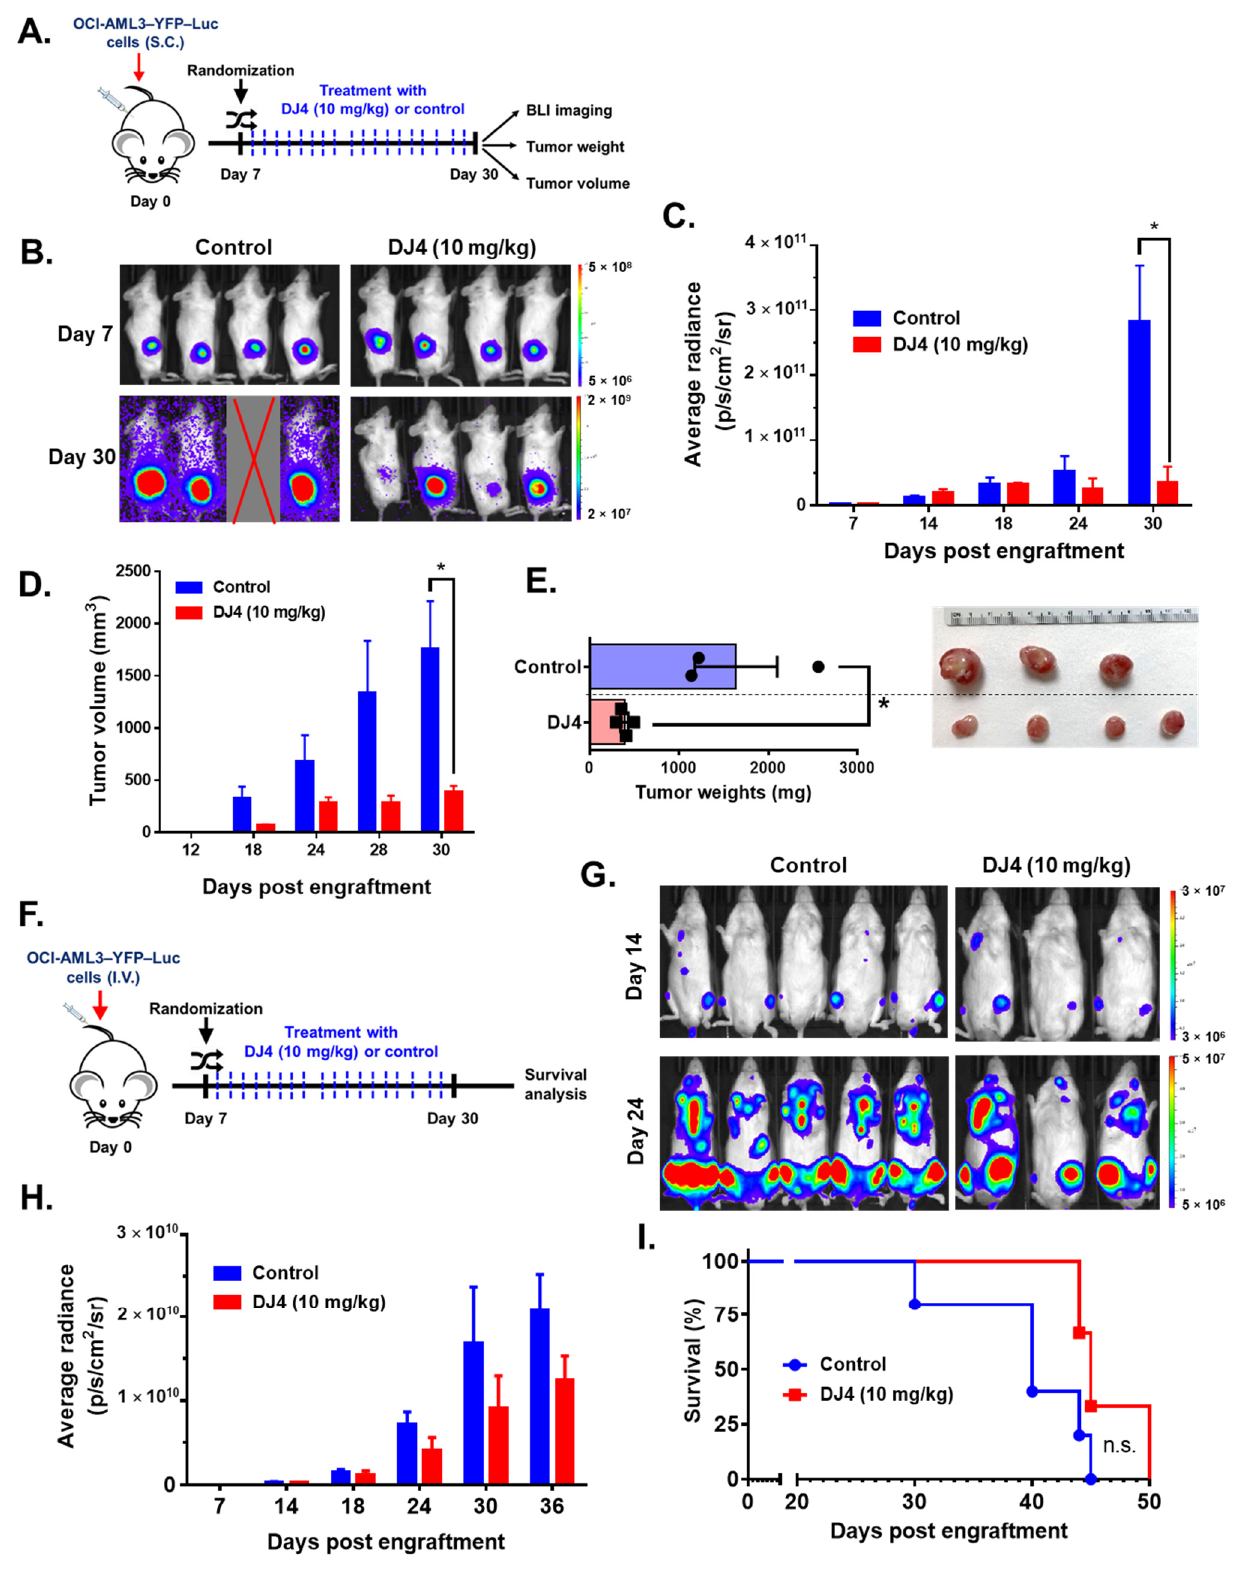
Figure 6. DJ4 administration (10 mg/kg) for three weeks was efficacious in the disseminated and subcutaneous models of OCI-AML3–YFP–Luc-injected mice. ( A ) The labeled OCI-AML3 cells were administered subcutaneously to the immunocompromised NRG-S mice and segregated into treatment groups based on their bioluminescent signal on day seven. The mice were subdivided in a manner to ensure the average signal between both groups was comparable at the start of the study and then treated with either the vehicle or DJ4. The average radiance (p/s/cm 2 /sr), tumor volume (mm 3 ), and tumor